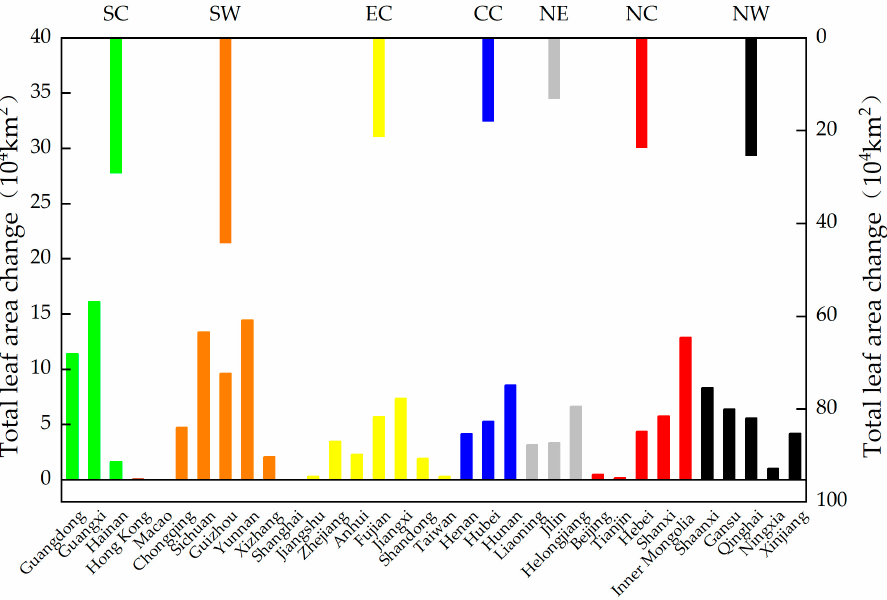
Figure 5. Provincial-level (the primary axis) and regional-level (the secondary axis) net changes in the total leaf area from 2000 to 2018.